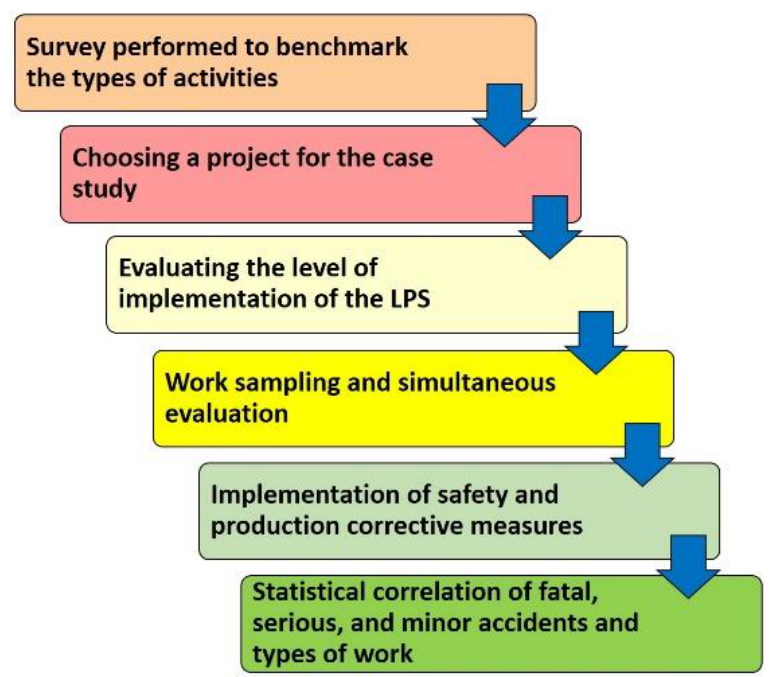
Figure 2. Research Figure 2. Research methodology